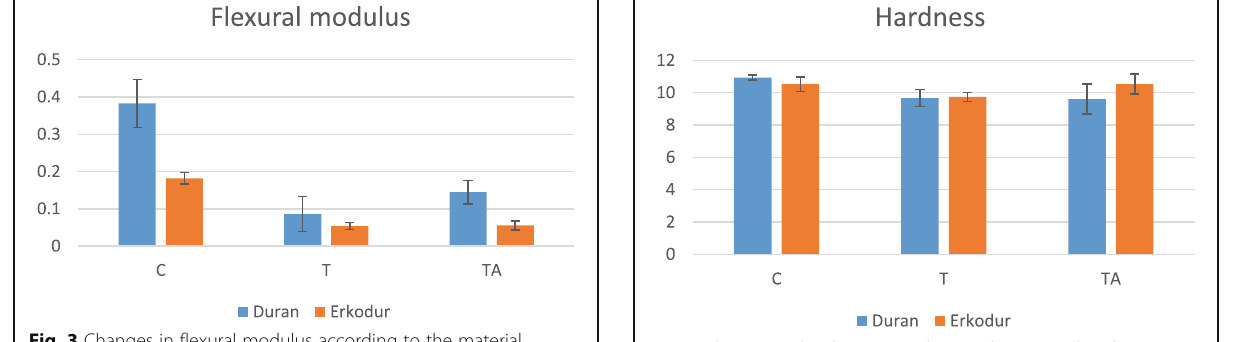
Fig. 4 Changes in hardness according to the material and groups